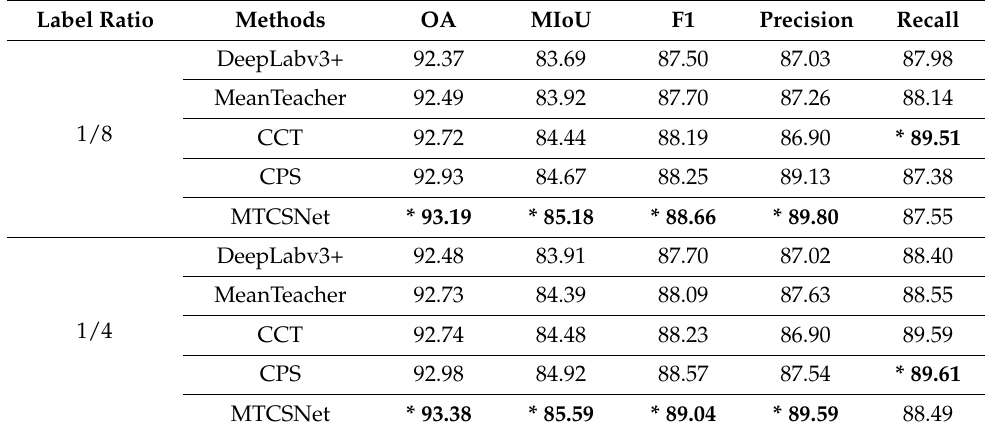
Table 6. Quantitative performance comparison on the GF1-WHU dataset. Label